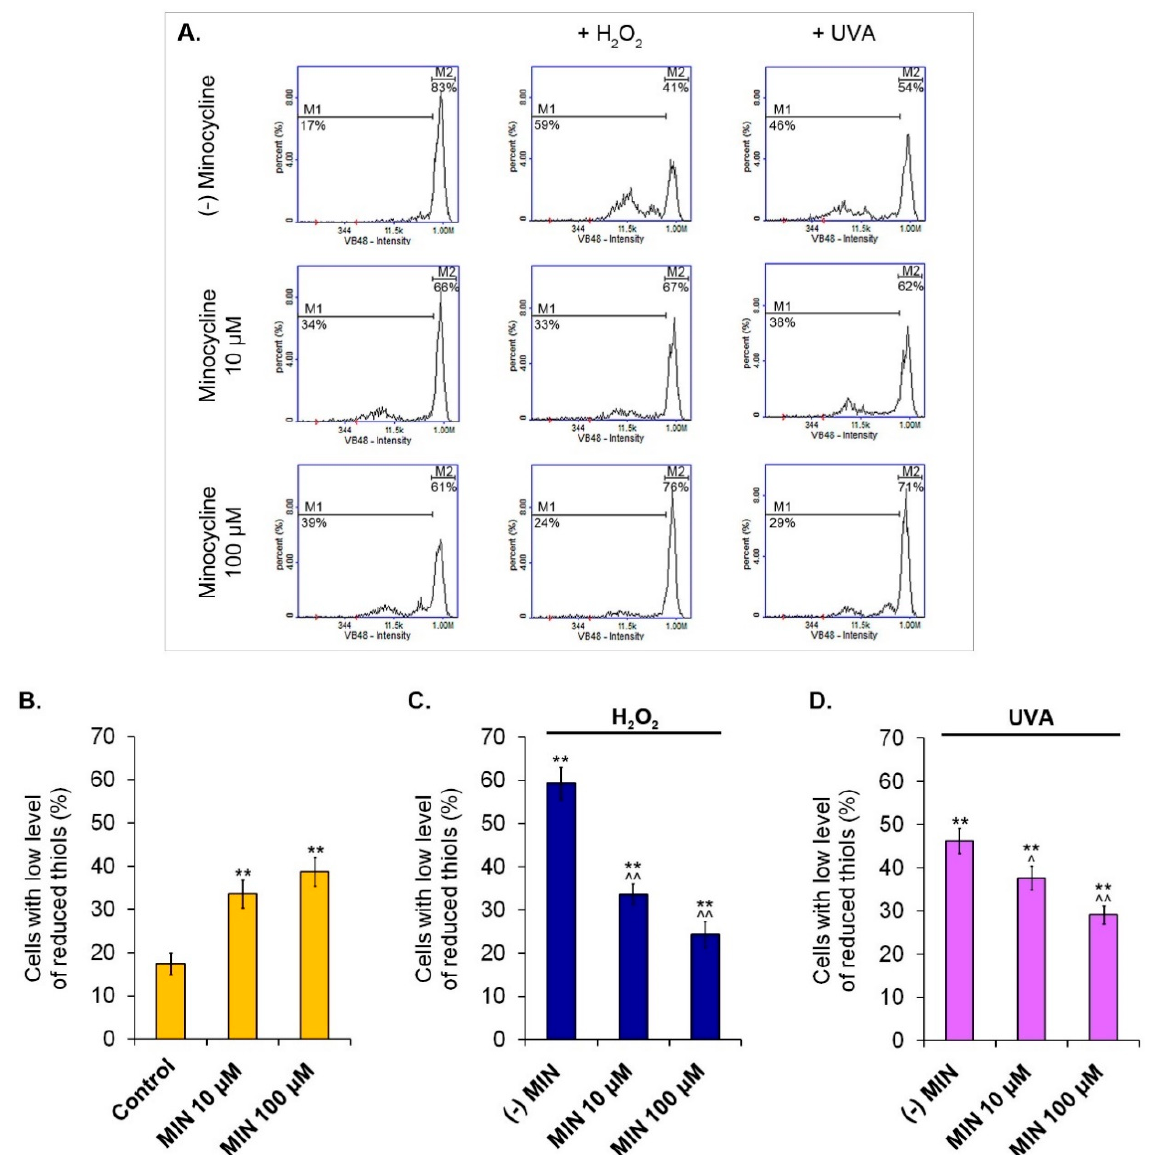
Figure 5. The influence of minocycline on intracellular level of reduced thiols in melanocytes. Representative histograms for individual samples: markers M1 and M2 respond to melanocytes with low and high level of reduced thiols, respectively ( A ). Mean values of the percentage of melanocytes with low level of reduced thiols were presented in the bar graph: for cells treated with minocycline ( B ) as well as additionally exposed to hydrogen peroxide ( C ) and irradiated with UVA ( D ). ** p < 0.005. vs control; ^ p < 0.05, ^^ p < 0.005. vs (-) MIN.